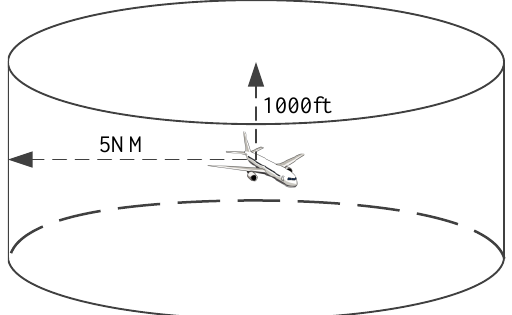
Figure 1. Safety cylinder around